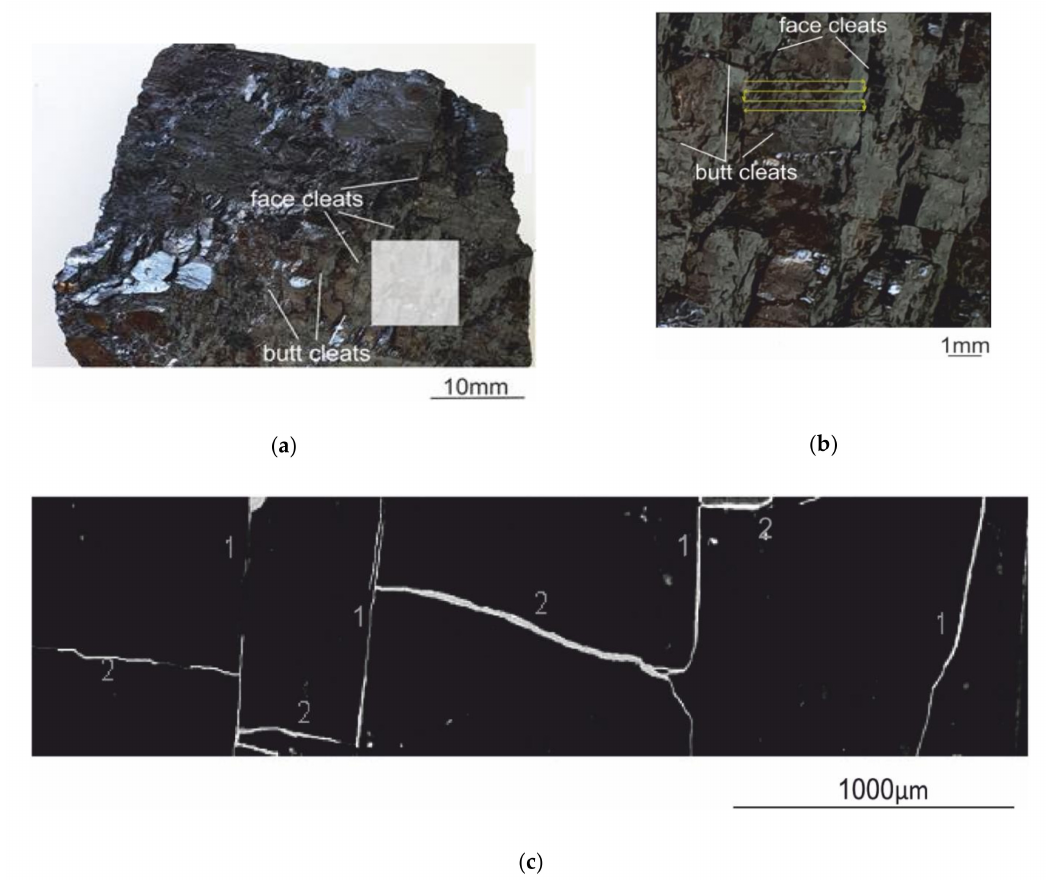
Figure 4. Coal sampling to perform microstructural analysis on planes perpendicular to the face and butt cleat direction: ( a ) site for manufacturing of the polished sections; ( b ) linear profile to measure the required parameters; ( c ) photo of the polished section under a microscope, which was converted into a binary form of images. 1—face cleats, 2—butt